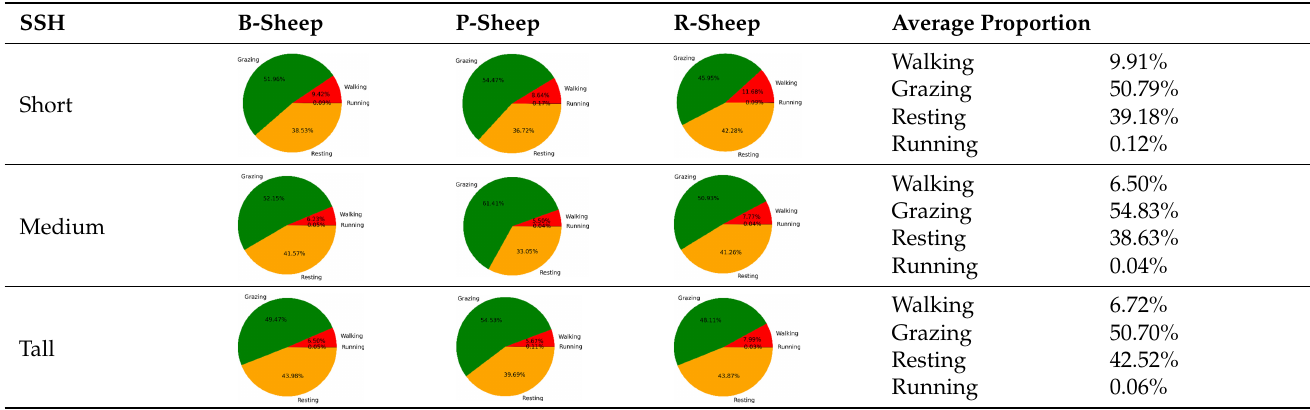
Figure 12. Behavior distribution of three grazing sheep on pastures with three different sward sur- face heights (SSH) classified by the trained stacking model. Table 9. Percentage of behavior time of the three grazing sheep for 7.5 h on pasture with three dif- ferent sward surface heights (SSH).